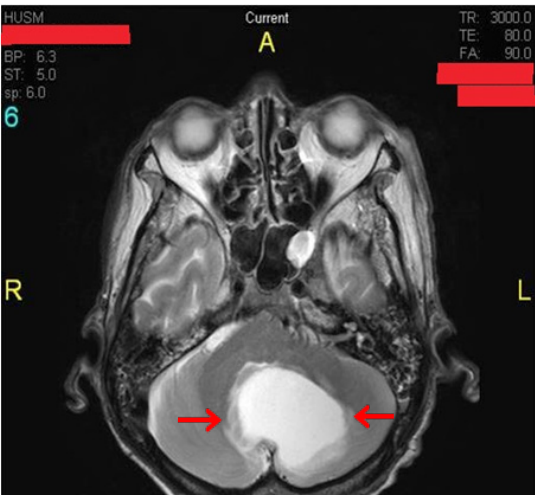
Legend: Figure 1 shows a right upper lobe collapse (red arrow) with loss of pul- monary vascular markings. The trachea also deviated towards the right side. Figure 2. T2-weighted MRI of the Patient.